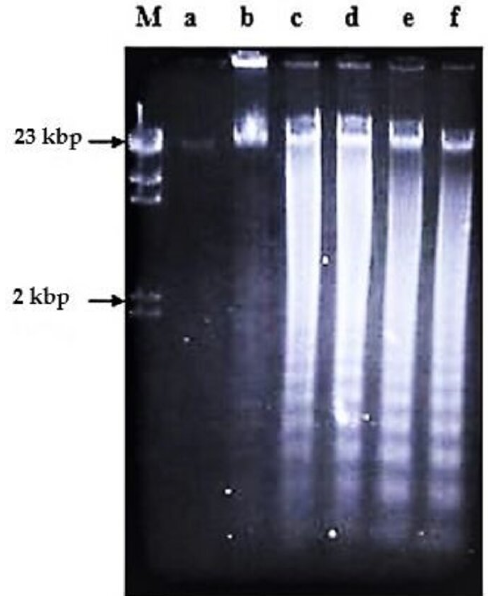
Figure 6. The involvement of phosphatases and RNA synthesis in nordamnacanthal-induced apop- tosis in CEM-SS cells at 24 h. Okadaic acid and actinomycin D failed to prevent apoptosis induced by 10 μg/mL of nordamnacanthal at 24 h. Lane a: control. Lane b: nordamnacanthal (10 μg/mL). Lane c: okadaic acid (100 nM). Lane d: nordamnacanthal (10 μg/mL) + okadaic acid (100 nM). Lane e: actinomycin D (1 μg/mL). Lane f: nordamnacanthal (10 μg/mL) + actinomycin D (1 μg/mL). Lane M: Marker (HindIII digest of lambda DNA).